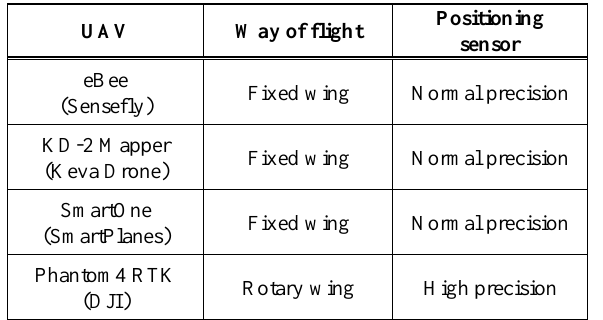
Table 1. Descriptions of the UAVs used